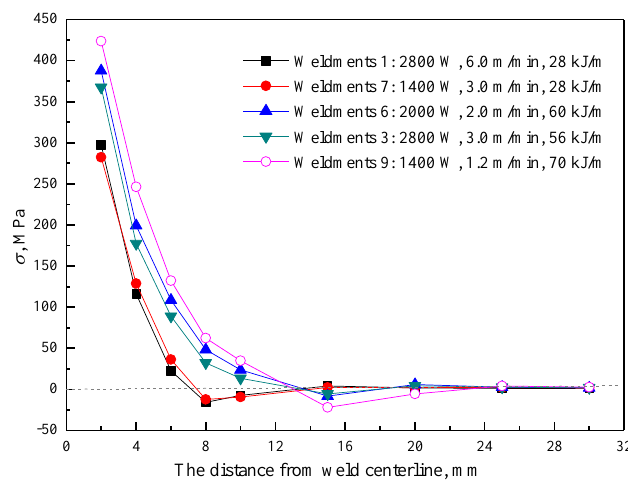
Figure 8. Longitudinal residual stress distribution with different heat inputs.